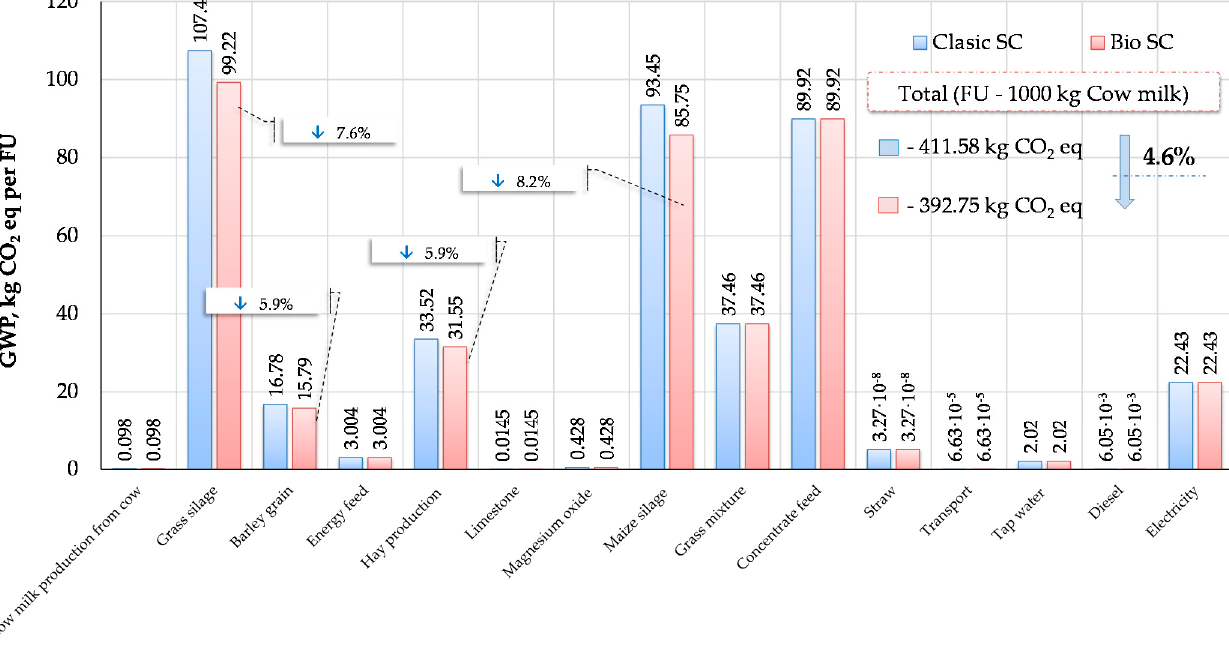
Figure 4. GWP of milk production stocks per FU.